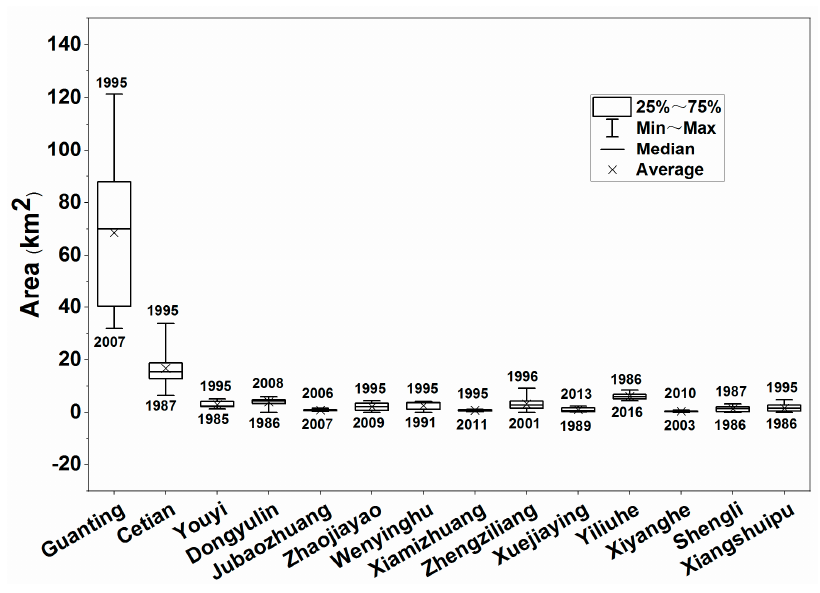
Figure 3. Landsat-derived annual surface water extent dynamics during 1985-2016 in YDRB.